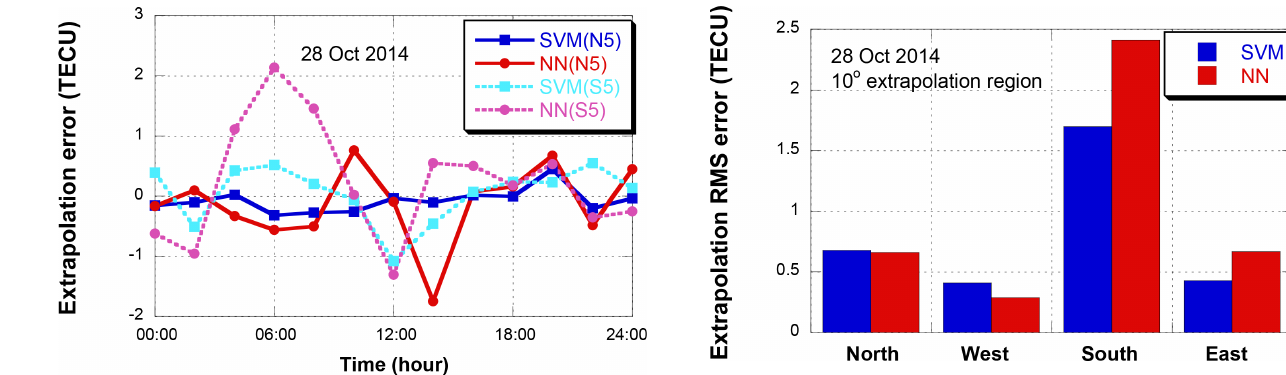
Figure 8. Extrapolation error variations on 28 October 2014 (north 5 ◦ and south 5 ◦ points).